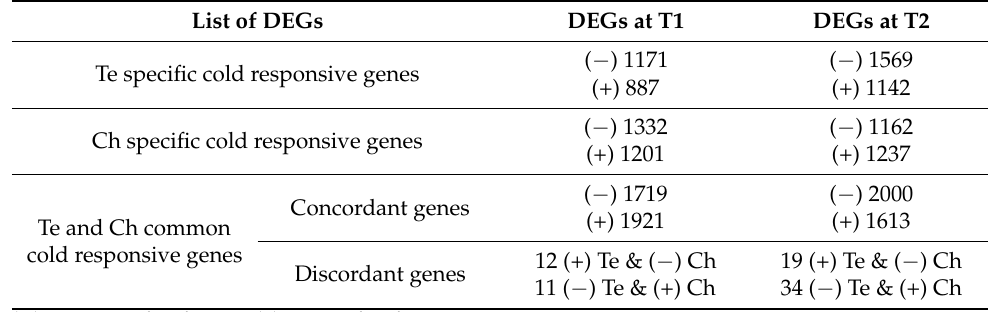
Table 1. Summary of DEGs identified in Champagne (Ch) and Térèse (Te) in response to cold in time periods T1 and T2 (adjusted p -values < 5%).